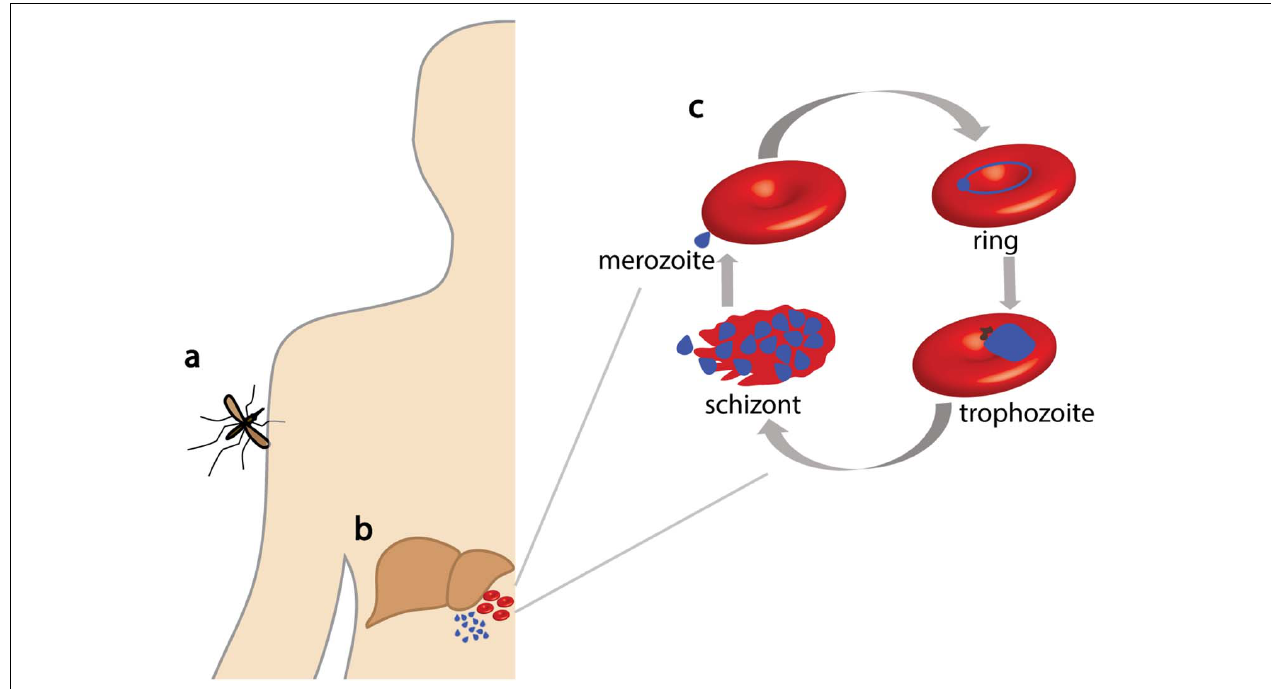
FIGURE 1 | Lifecycle of Plasmodium falciparum . P. falciparum parasites are injected into a human host via mosquito bites (a) where they then travel to the liver (b) . After parasite replication, merozoites are released into the blood where they invade erythrocytes to commence the asexual replication cycle (c) . Parasites develop within the erythrocyte in distinct forms (ring, trophozoite, and schizont) until erythrocyte lysis occurs, releasing merozoites for